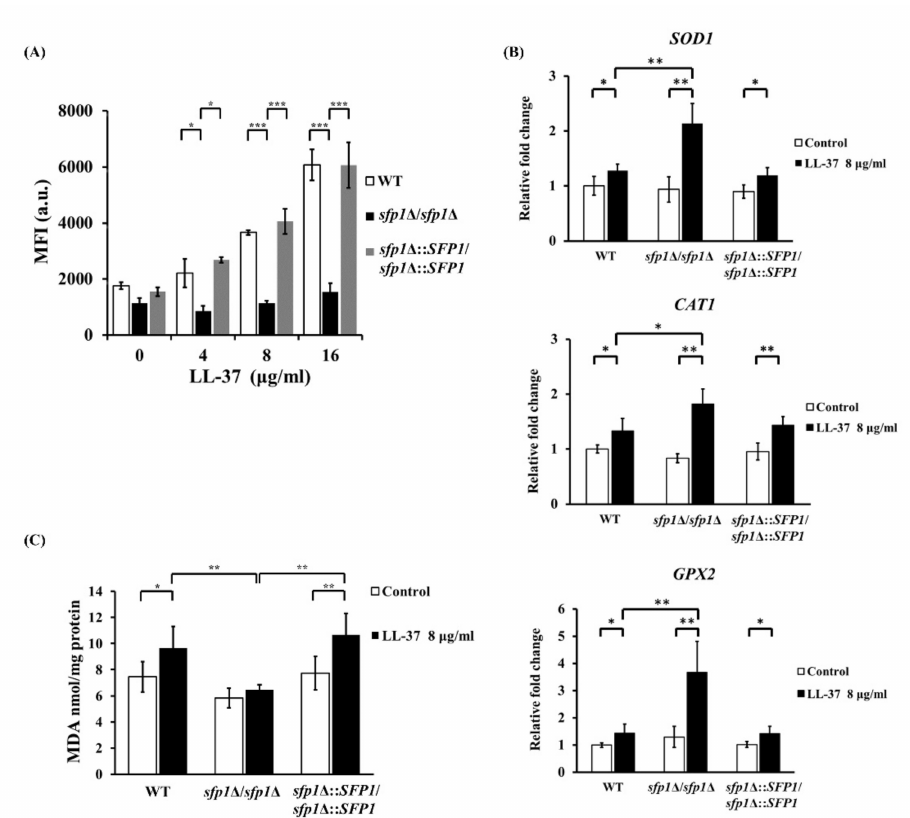
Figure 5. Oxidative stress in cells treated with or without LL-37. ( A ) To measure intracellular ROS accumulation, cells were treated with the indicated concentrations of LL-37 for 30 min, followed by incubation with 20 µ g/mL H 2 DCFDA. The mean fluorescence of 10,000 cells was determined by flow cytometry. The results are expressed as the mean ± SD of three independent assays. * p < 0.05; *** p < 0.001. ( B ) The expression of antioxidant genes was detected using real-time quantitative PCR. The PMA1 transcripts were used as an endogenous control. The results are expressed as the mean ± SD of three independent assays. * p < 0.05; ** p < 0.01. ( C ) Detection of lipid peroxidation as a marker of oxidative stress. Cells were treated with or without LL-37 (8 µ g/mL) for 30 min, and the MDA level was measured. The results are expressed as the mean ± SD of three independent assays. * p < 0.05; ** p <